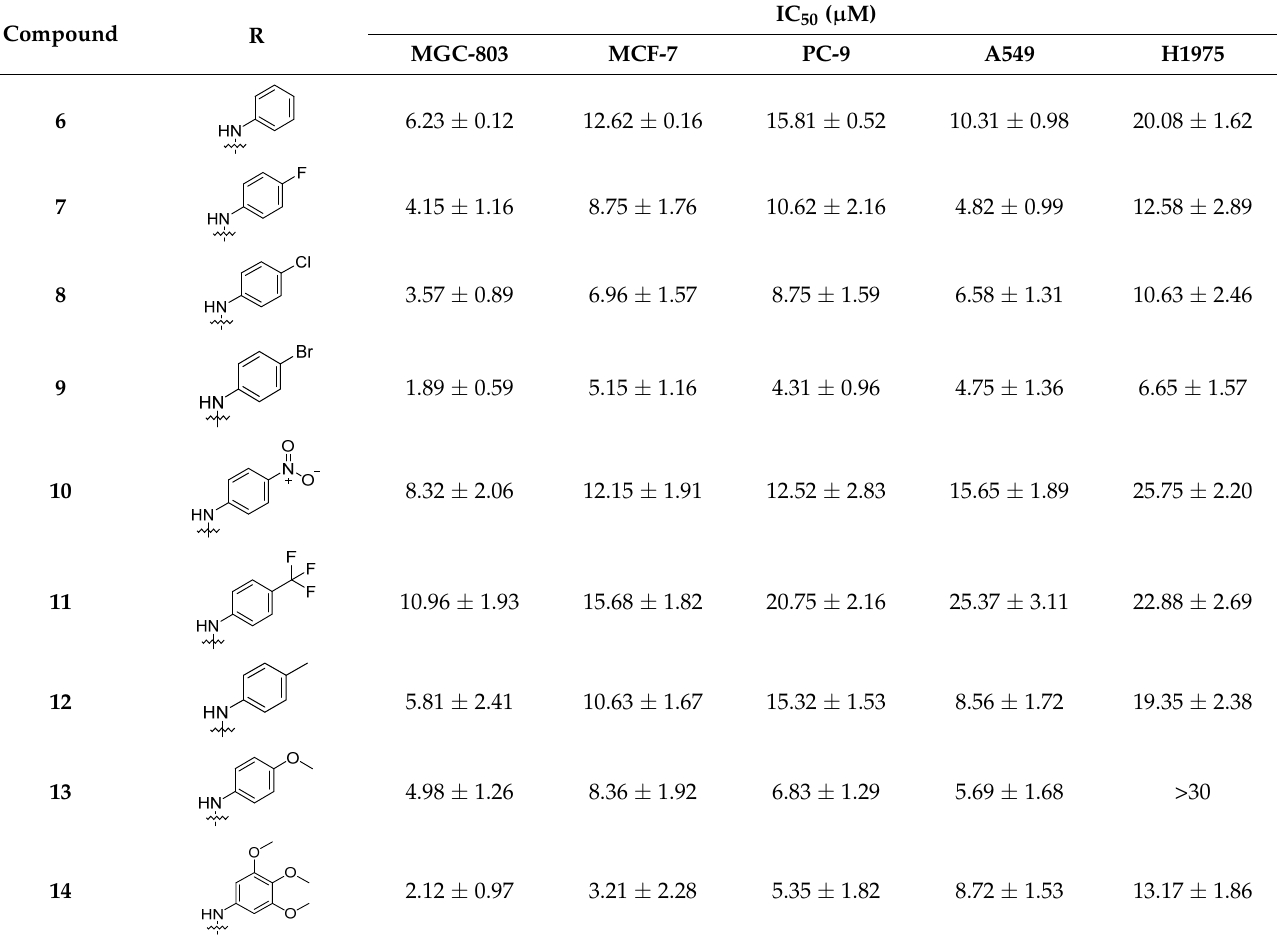
Table 1. Antiproliferative activity of compounds 6 – 19 against selected cell lines.